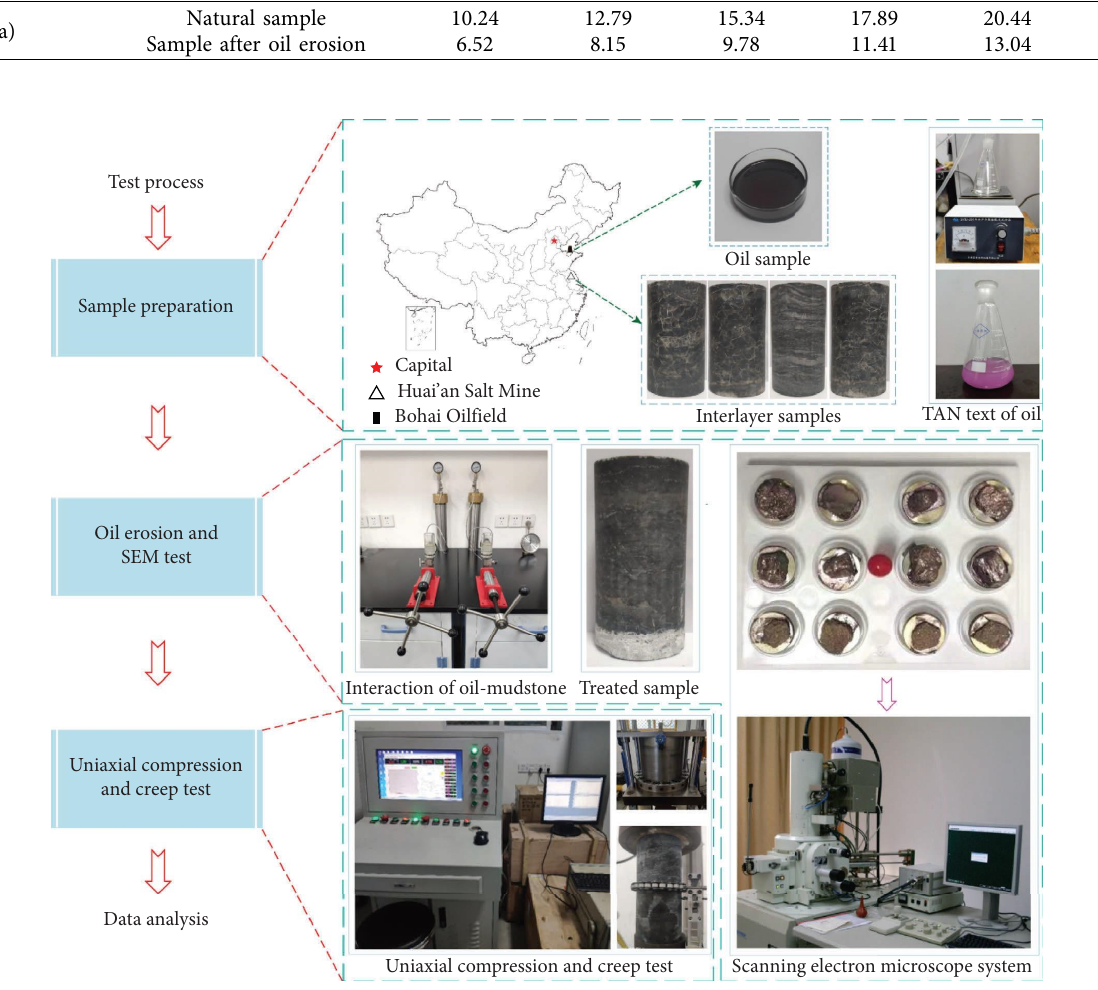
Figure 3: Experimental procedures.